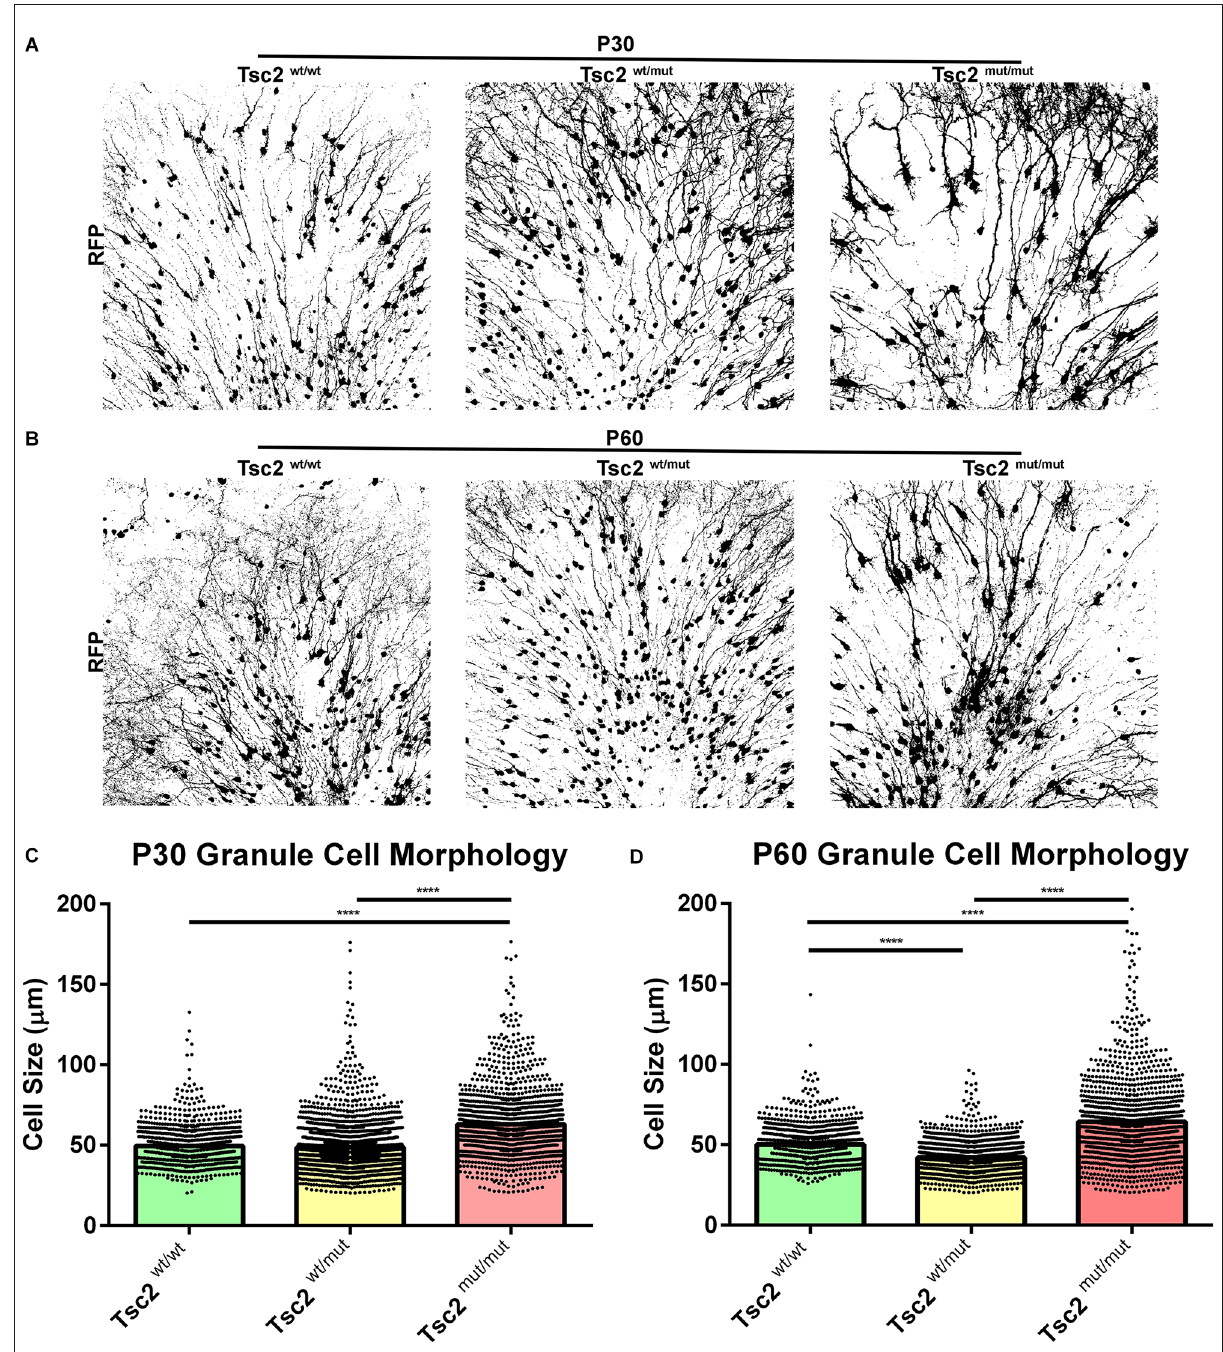
FIGURE5 Loss of Tsc2 causes GC cytomegaly. (A) P30 OB GC Z projection converted to binary. (B) P60 OB GC Z projection converted to binary. (C) Quantification of cell size at P30. (D) Quantification of cell size at P60. **** p < 0.0001.